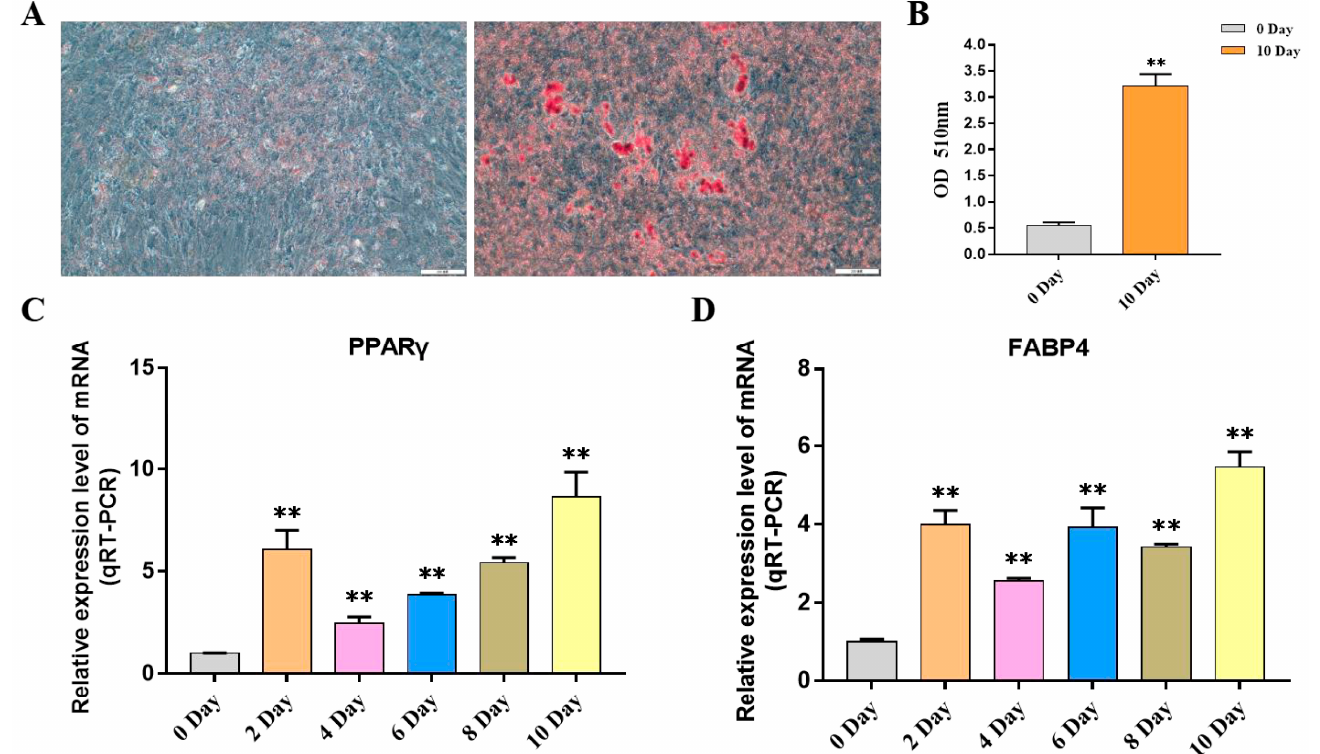
Figure 7. Induction of primary adipocyte differentiation. ( A ) Oil red O assay for lipid droplet distribution in adipocytes on day 0 and day 10 of differentiation. ( B ) The absorbance of adipocyte extract at 510 nm was measured at 0 and 10 days after induction. ( C , D ) The expression of PPAR γ and FABP4 genes was detected. Compared with the control, “**” means an extremely significant difference ( p < 0.01).